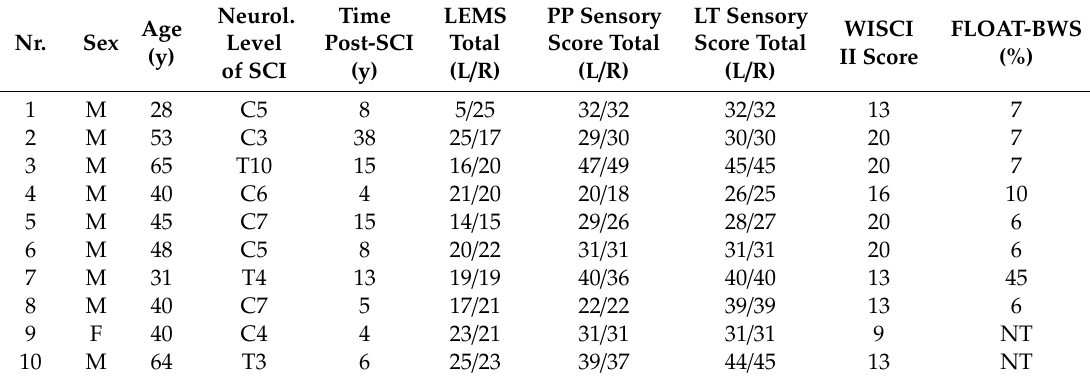
Table 1. Neurological status of the participants according to the International Standards for Neurological Classification of Spinal Cord Injury. Neurol. Age Nr. Sex Level (y)